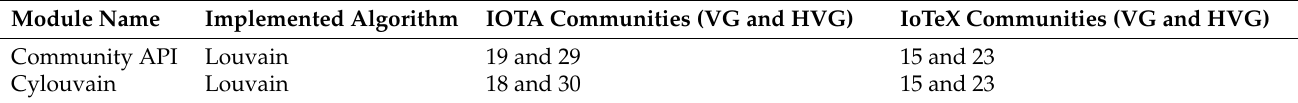
Table 7. Community searching Python modules.